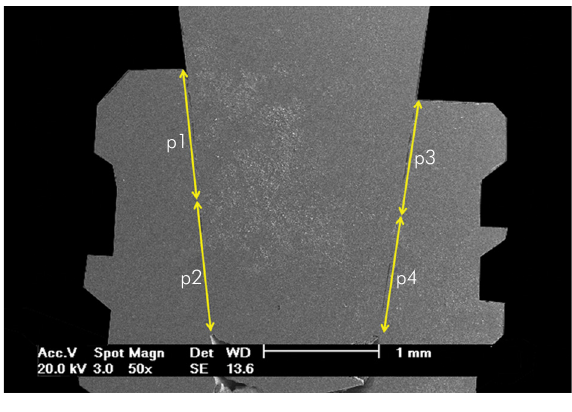
Figure 5. Scheme of the locations (positions) defined for the measurements of the linear contact between abutment and